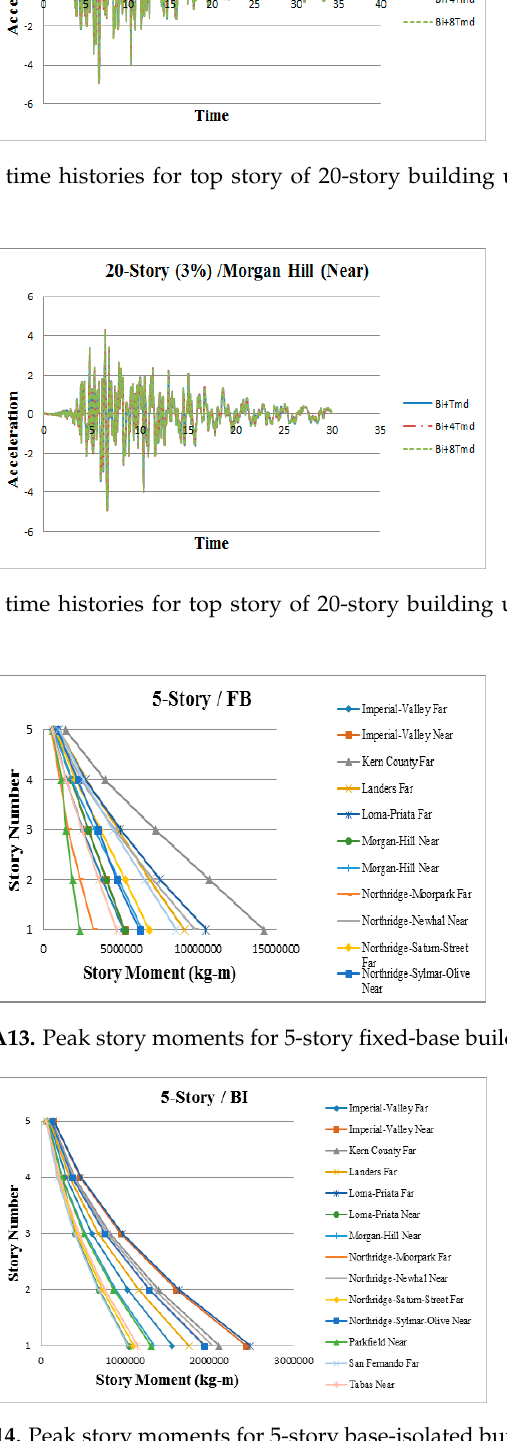
Figure A14. Peak story moments for 5-story base-isolated building.